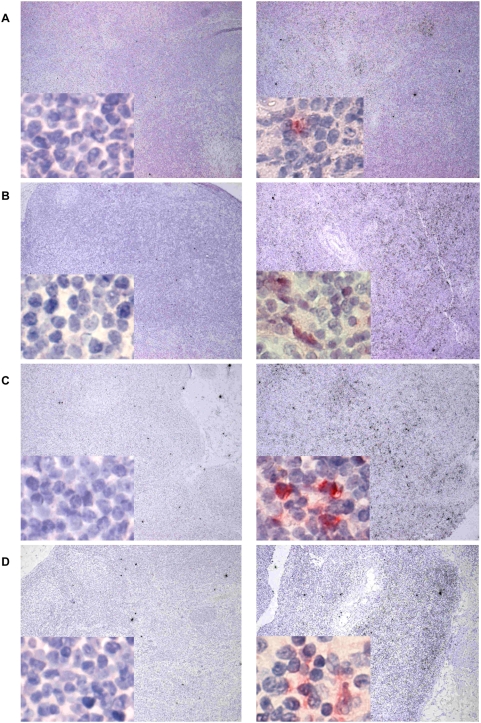
Upregulation of CXCL10 and CXCL9 in draining lymph nodes following injection of poly ICLC.Expression of CXCL10 (A,B) and CXCL9 (C,D) mRNA (in situ hybridization) and protein (insets) in control lymph nodes before (left panels) and in draining lymph nodes (right panels) 18 hours after KLH-immunization with 0.5 (A,C) or 0.1 mg/kg (B,D) poly ICLC, respectively. The presence of chemokine mRNA is shown by the black dots in the T cell area (100× magnification). Cells positive for chemokine protein expression are visible in red (insets: 400× magnification). Immunohistochemistry was performed on sections consecutive to the one in which in situ hybridization was performed to confirm protein expression. Data are representative for two animals for each dose of poly ICLC.